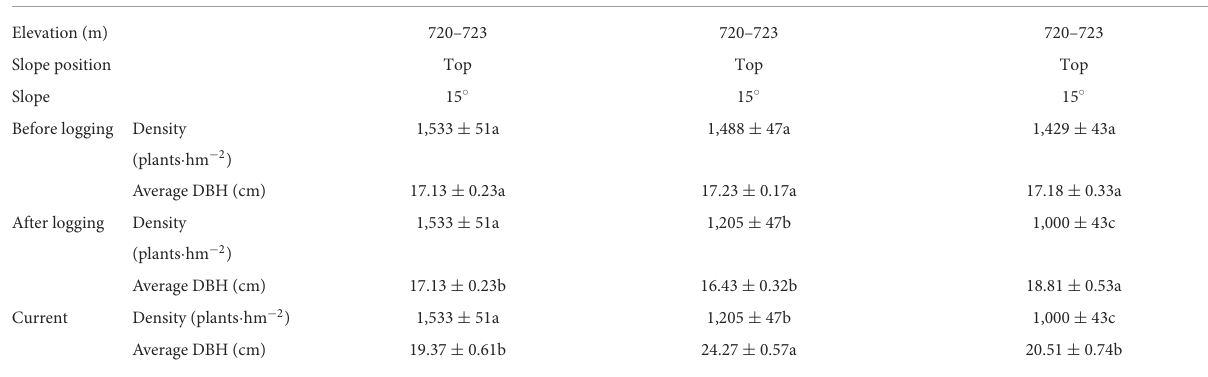
TABLE 1 The basic information of sample